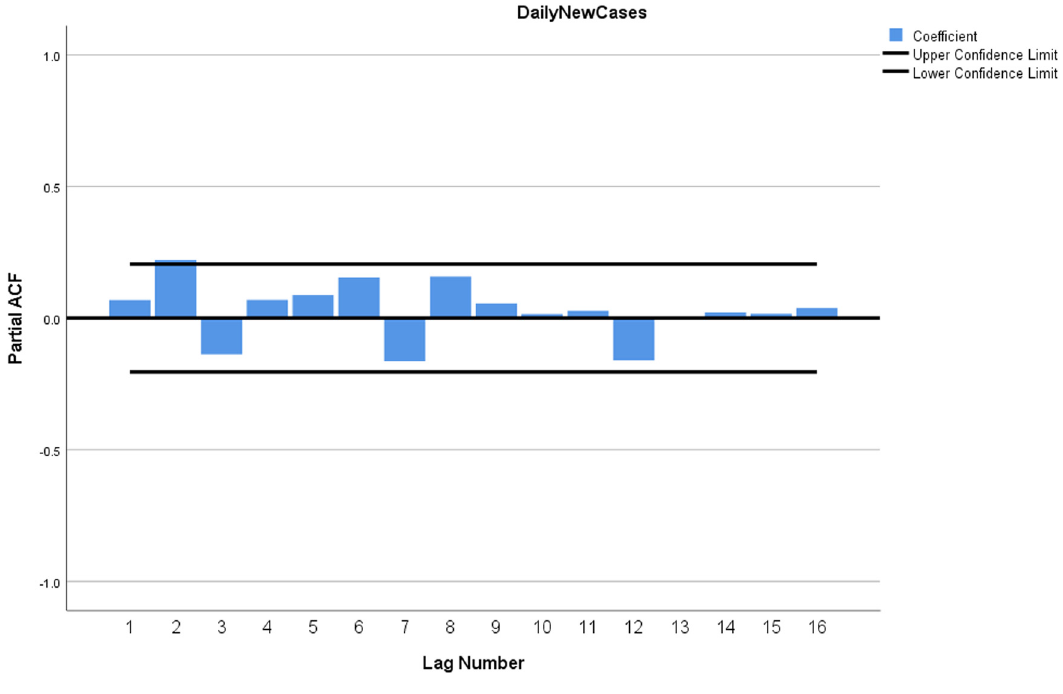
Figure 5: PACF of the di ff erenced series.